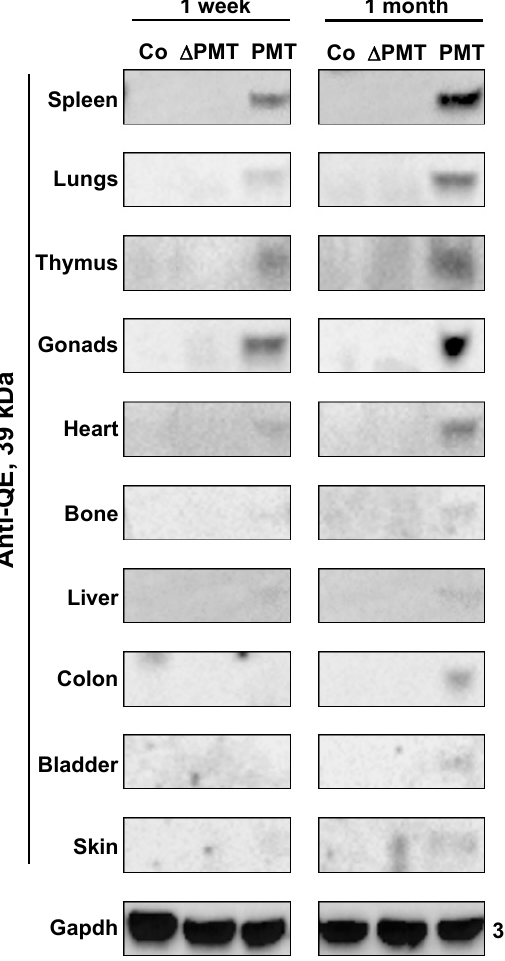
Figure 2. PMT modifies G-proteins in vivo. Western blot analysis of PMT-modified G-alpha protein subunits in whole-tissue extracts of mice treated with PMT (3 ng), mutant PMT ( ∆ PMT; 3 ng) or vehicle control (Co) for either one week or one month as indicated. Extracts were immunoblotted with a specific anti-QE antibody as described in the Methods. Gapdh was used as a loading control.